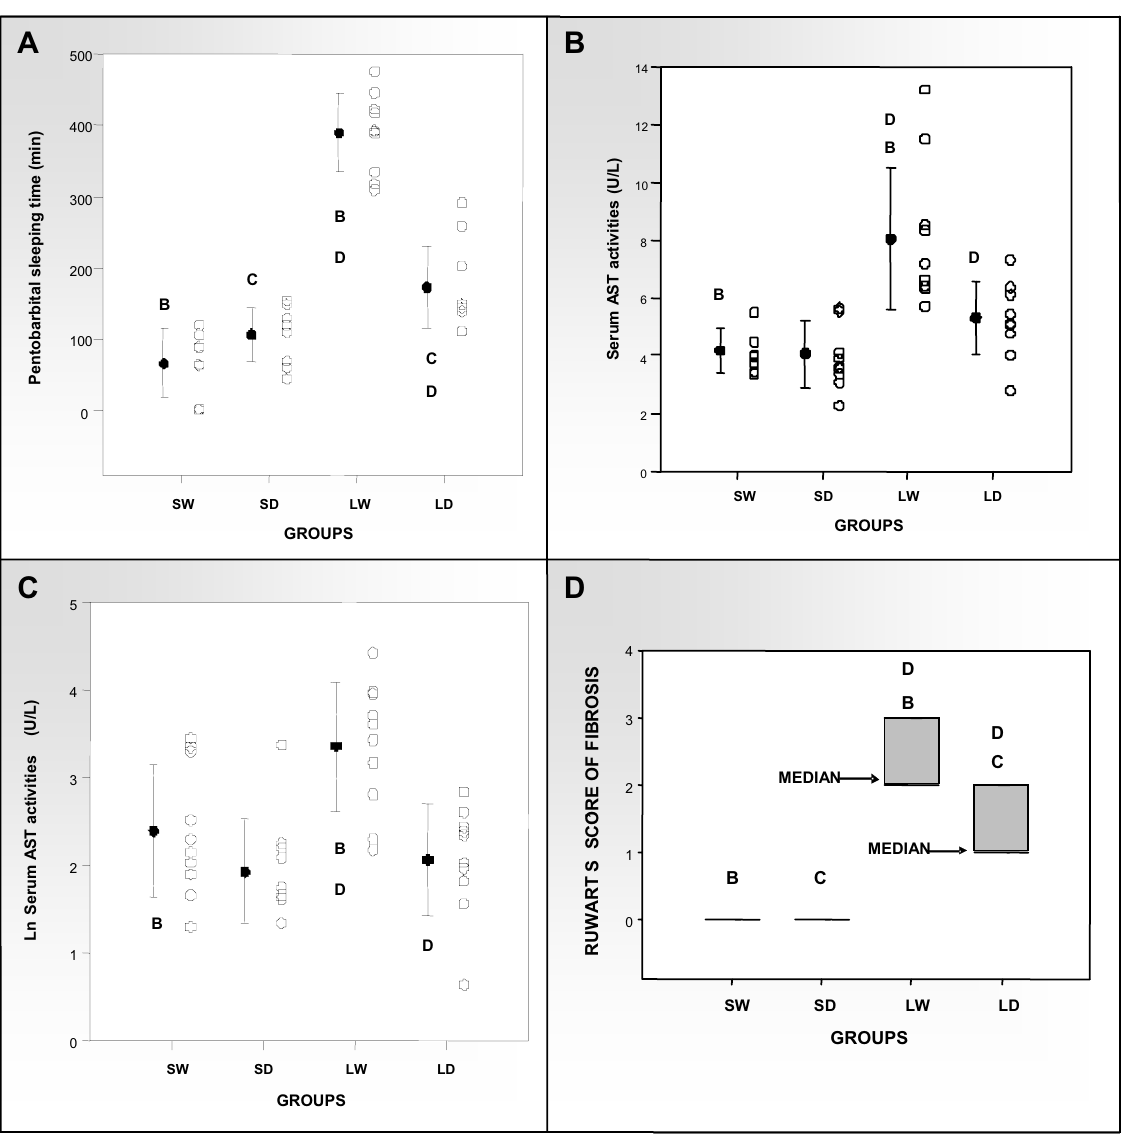
FIGURE 1 – Means, standard deviations and individual values of: ( A ) pentobarbital sleeping time (min.); ( B ) aminotrans- ferase serum activity AST (IU/L); ( C ) aminotransferase serum activity ALT (IU/L); ( D ) Ruwart´s score for fibrosis in rats in groups of 10, submitted to one of the following treatments: SW : sham operation with daily administration of water; SD : sham operation with daily administration of BEP; LW : double ligature with common bile duct resection with daily administration of water; LD : double ligature with common bile duct resection with daily administration of BEP. Letters repeated indicate the paired groups with significant differences (p<0.05): between them in the Tukey Test (A,B,C) or in the SNK test (D). A =SW>SD; B =LW>SW; C =LD>SD; D